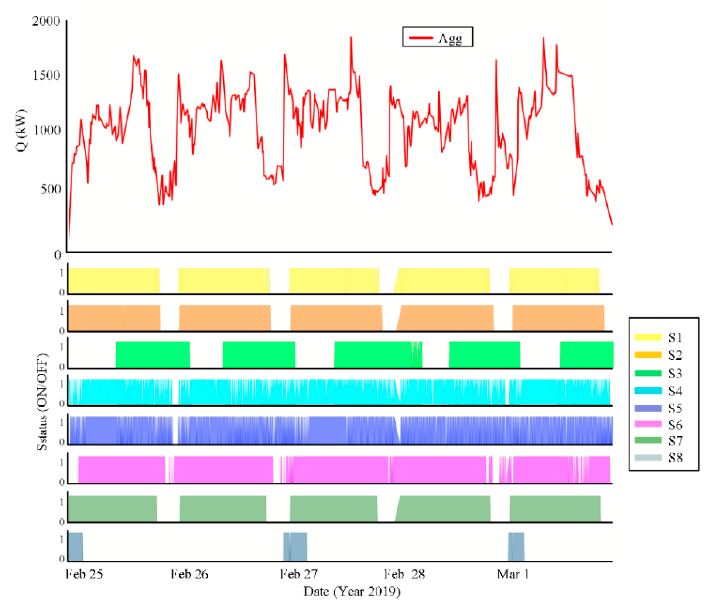
Figure 7. Aggregated cooling consumption and state of each S. Processes 2020 , 8 , x FOR PEER REVIEW